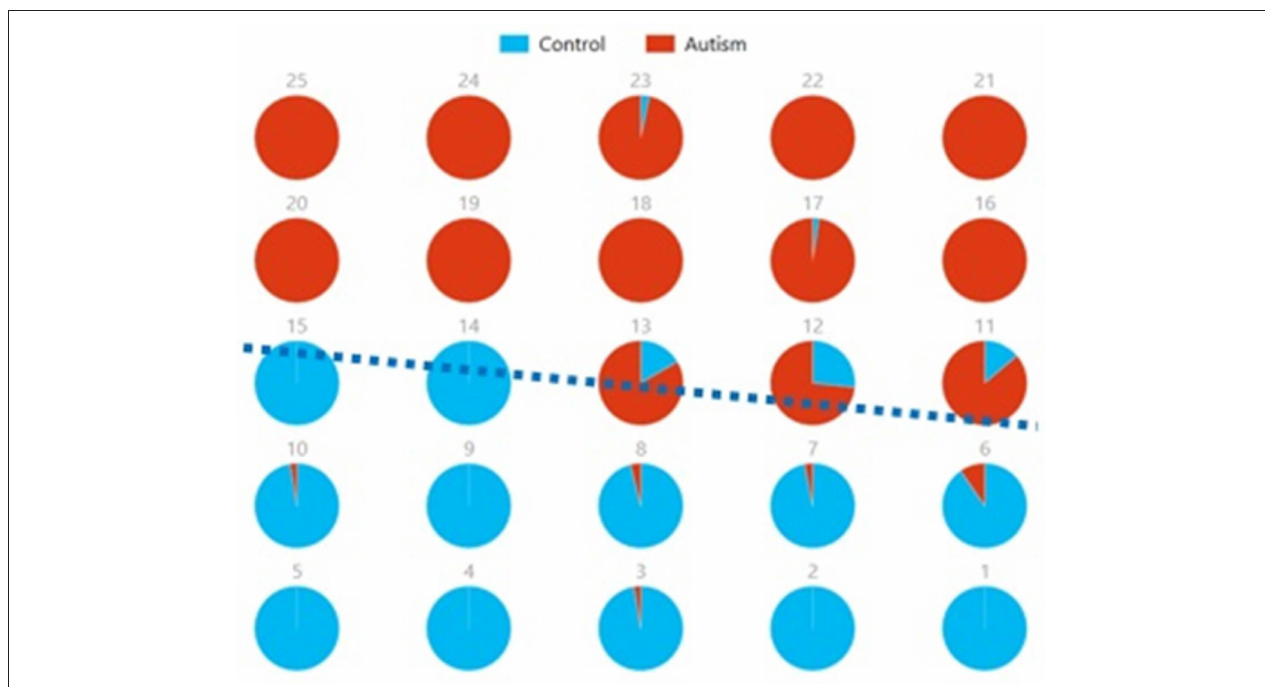
FIGURE 10 | Pie chart visualizations based on a 5 × 5 SOM for A x and C x showing Autism and Control groups by neuron. Each pie chart corresponds to a neuron, represented by the number on each chart, in the SOM map for these components. This map indicates group separation approximately in the middle with Autism group populating the upper while Control the lower half of the SOM, represented by the dotted blue line.